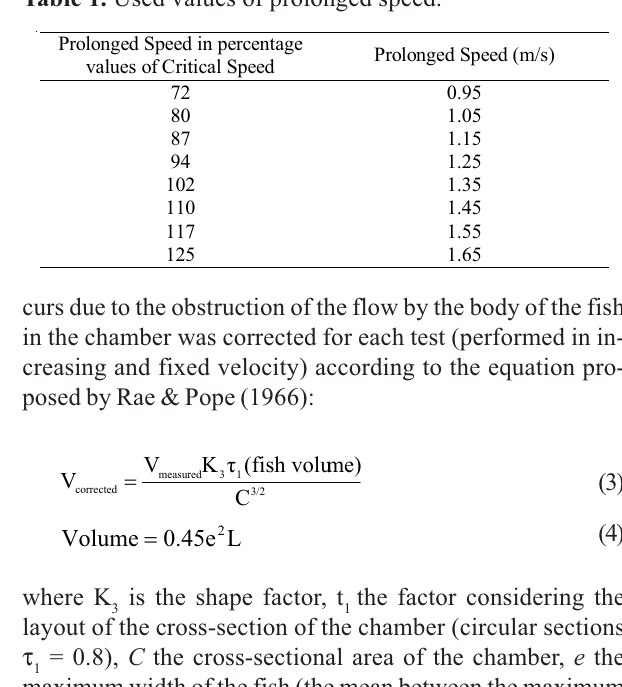
Table 1. Used values of prolonged